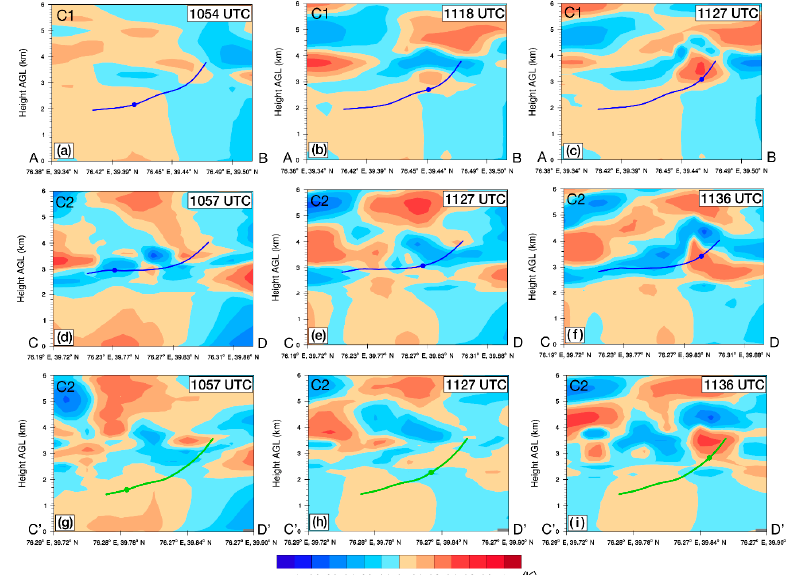
Figure 14. ( a – c ) Vertical cross sections of potential temperature anomaly (shading, unit: K) and averaged height of the backward trajectories (bold blue line) and air parcels (bold blue dot) (projected to the vertical cross section) selected within the C1 along the line segment AB in Figure 12a on 23 June 2015. ( d – f ) are the same as ( a – c ) but for the average height of the backward trajectories from southwest (blue lines in Figure 12b,c) along the line segment CD in Figure 12b. ( g – i ) are the same as ( d – f ) but for the average height of the backward trajectories from the south (green lines in Figure 12b,c) along the line segment C’D’ in Figure 12c. The specific time is shown in the upper right corner of each